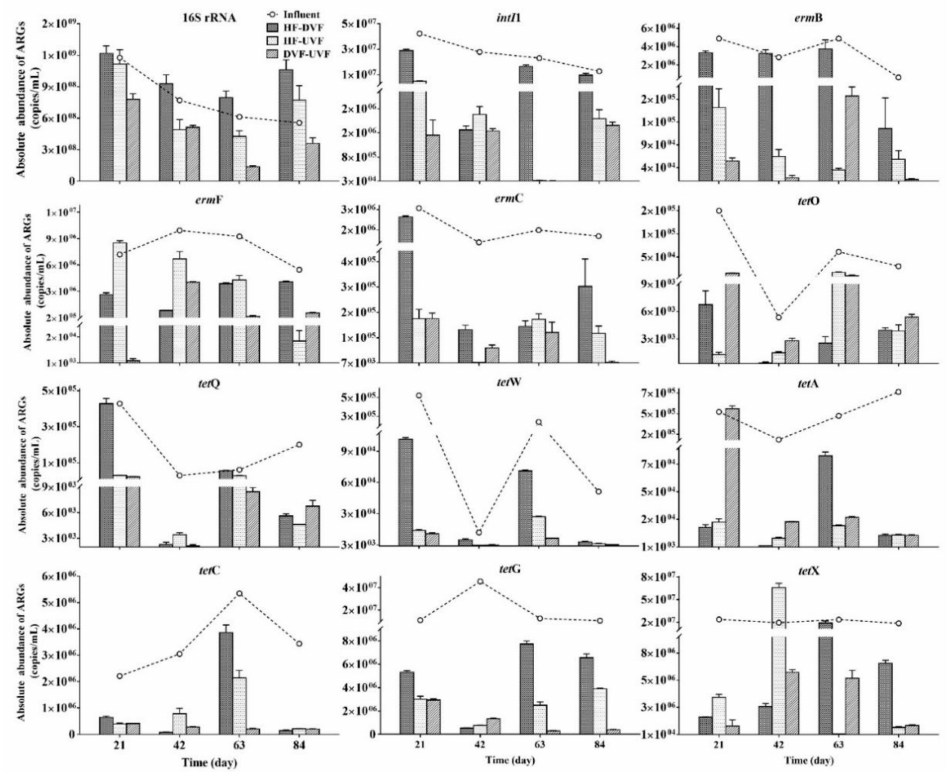
Figure 2. 16S rRNA, intI 1, and antibiotic resistant genes abundances in the influent and e ffl uent of di ff erent hybrid constructed